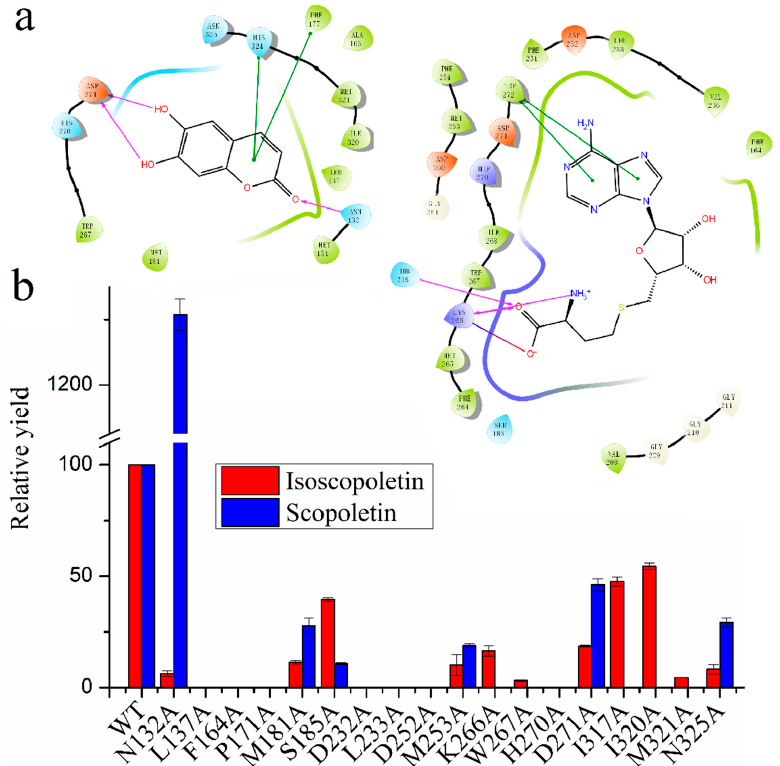
Figure 4. Docking of COMT-S with esculetin and S -adenosyl- L -homocysteine (SAH) ( a ) and the relative activity of COMT-S and its mutants toward esculetin ( b ). The activity of wild type COMT-S was calculated by its two products, isoscopoletin (red) and scopoletin (blue). Their yield was set as 100% for normalization. Analysis and reaction process is listed in the methods part. The data represents the means ± SD of three replicates.